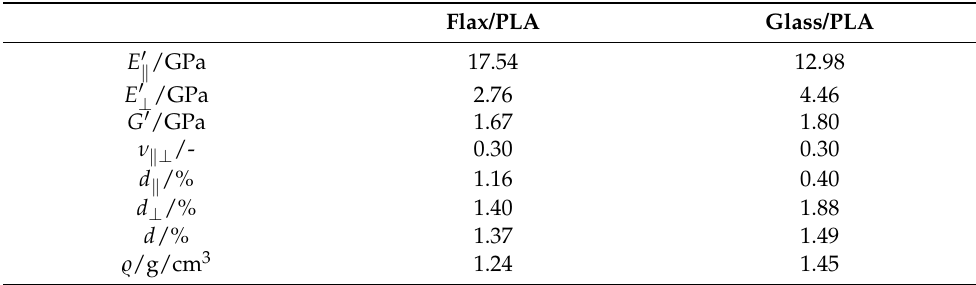
Table 1. Determined properties of the investigated